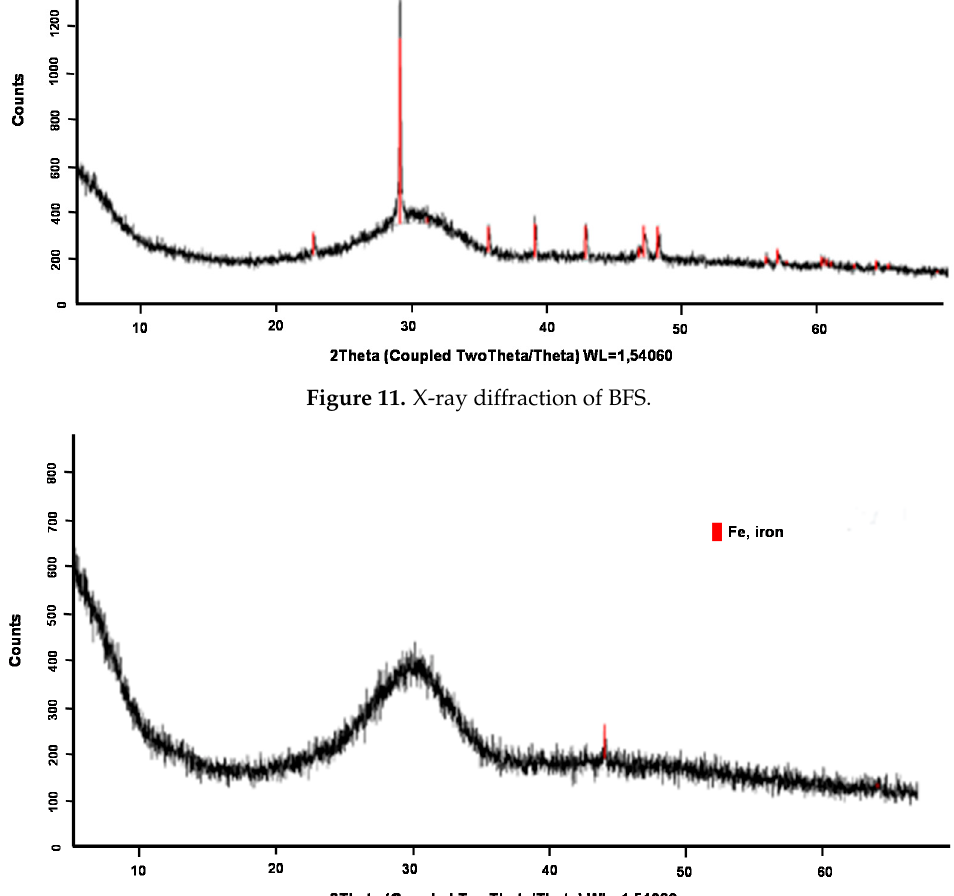
Figure 12. X-ray diffraction of SS.